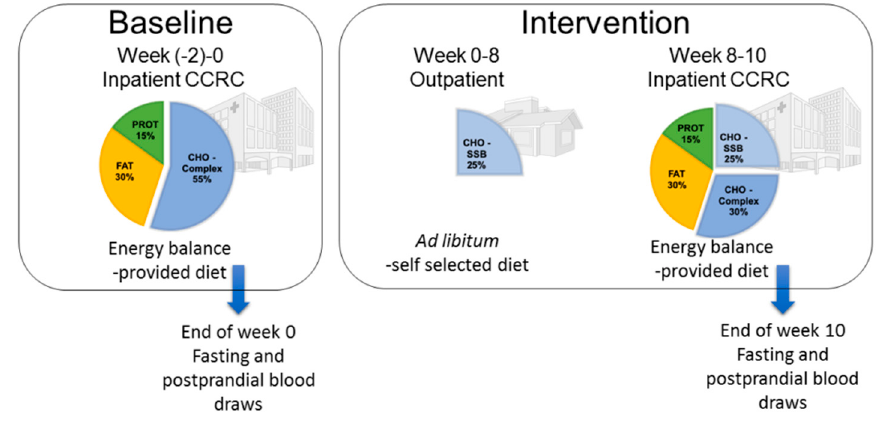
Figure 1. Study design and dietary protocol. CCRC: Clinical and Translational Science Center’s Clinical Research Center.